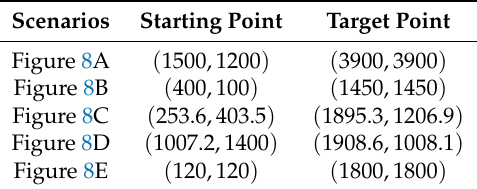
Figure 8. In this figure, five scenarios are shown and named A – E from left to right. Table 1. Scenario initialization